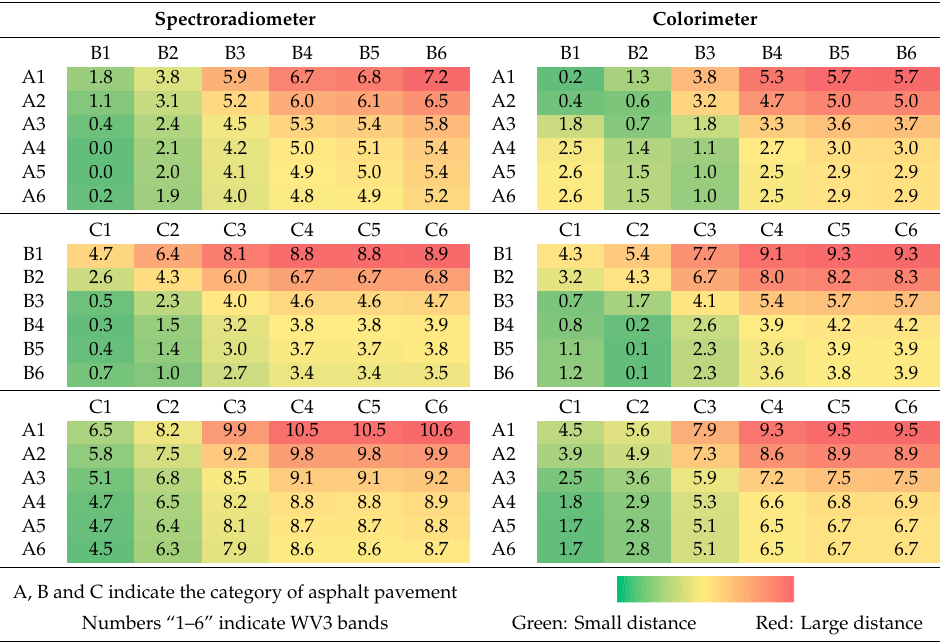
Table 6. Euclidean distance of WV3 bands in the visible spectrum for spectroradiometer (left) and colorimeter (right).